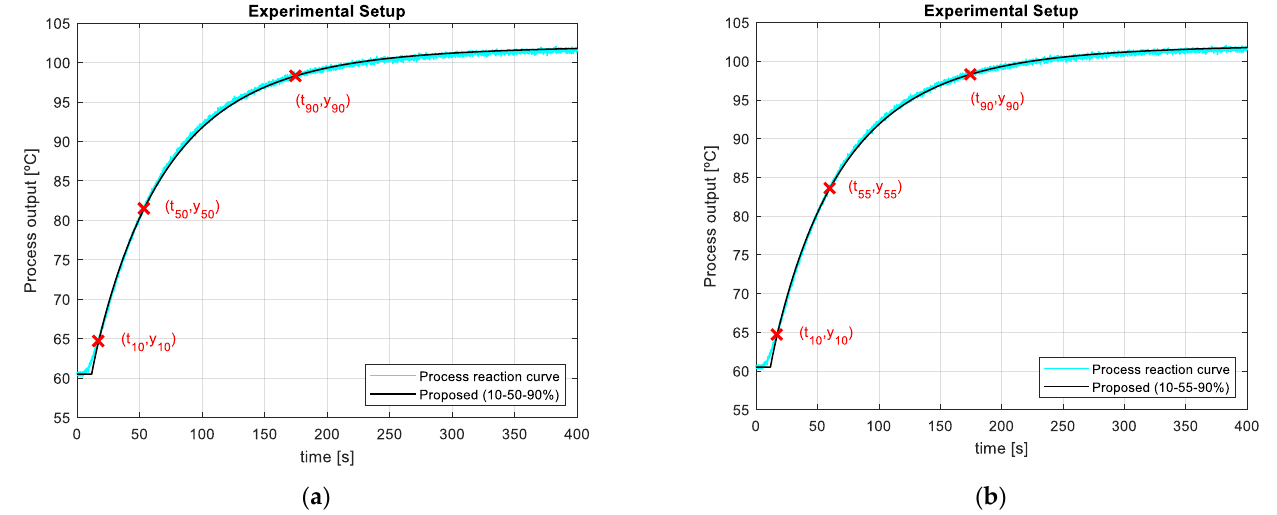
Figure 29. FFOPDT model step response using the proposed identification method for the experi- mental setup in a certain operating point and process reaction curve: ( a ) Symmetrical set of points (10-50-90%); ( b ) Asymmetrical set of points (10-55-90%).